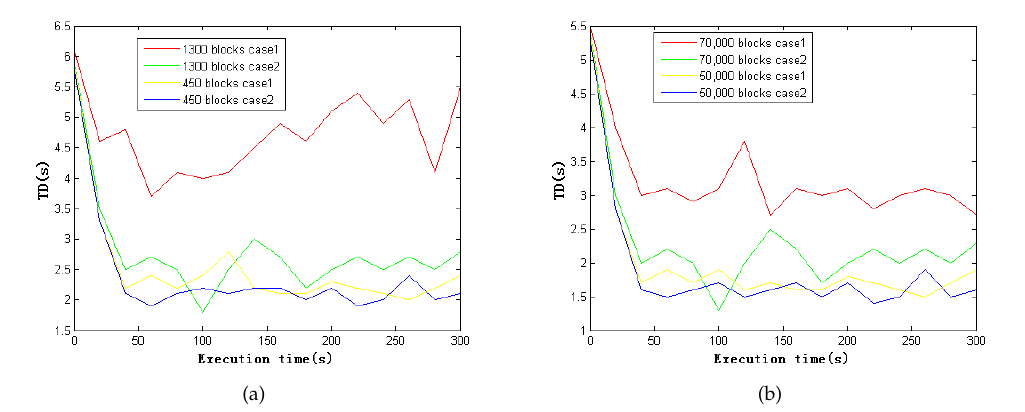
Figure 6. Processing time total delay(TD) with increased number of blocks. ( a ) TD with blocks in single node; ( b ) TD with blocks in